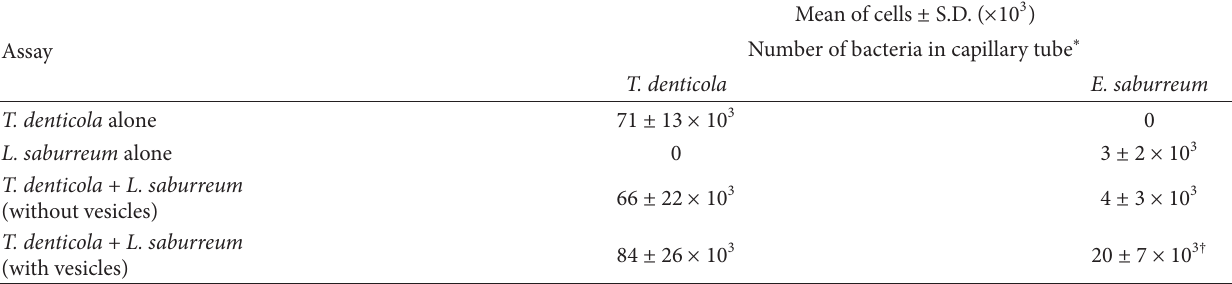
T 3: Effect of P. gingivalis outer membrane vesicles on the piggybacking of L. saburreum on T . denticola